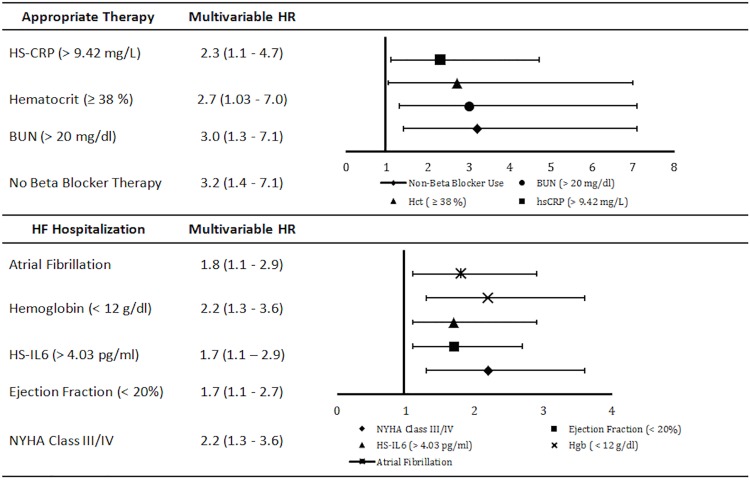
Multivariable hazard ratios for appropriate therapy and HF hospitalization.